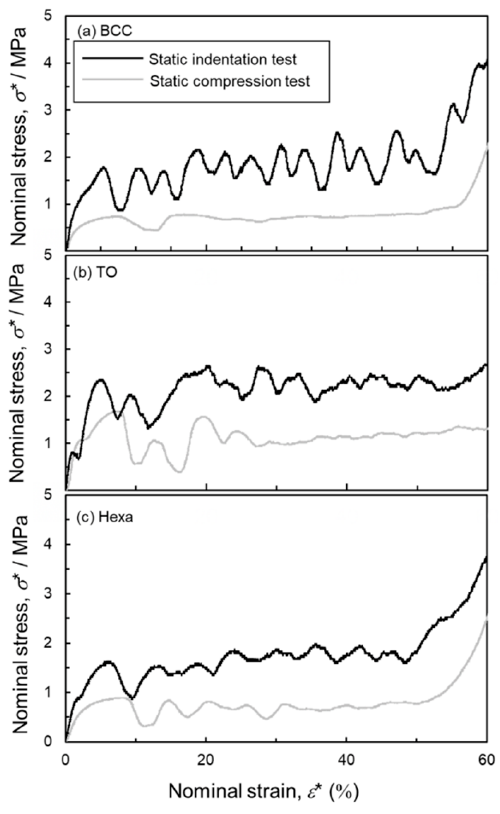
Figure 10. Nominal stress-strain curves measured by static compression and indentation tests of ( a ) BCC, ( b ) TO and ( c ) Hexa lattice specimens.